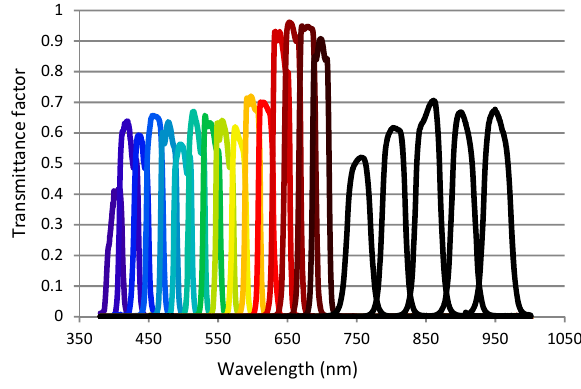
Figure 3. Transmittance factors as a function of wavelength for 21 dichroic filters in the visible and NIR spectrum.